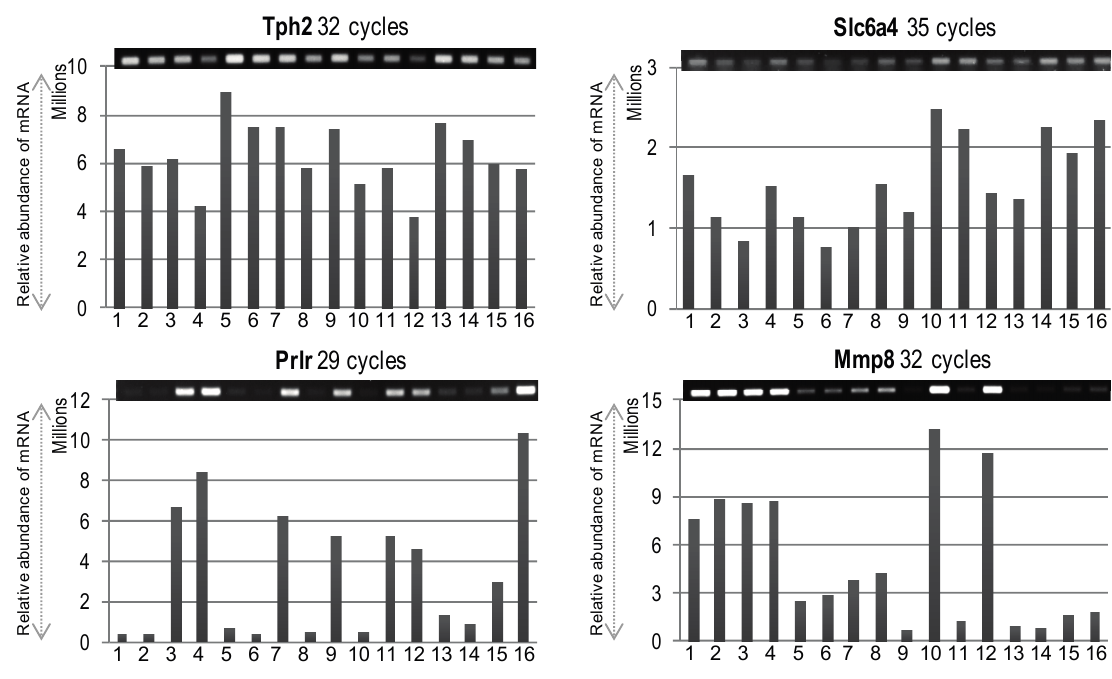
Figure 4. The mRNA expression profiles of differentially expressed down-regulated genes. Gel images on top show PCR product bands stained with ethidium bromide; band intensities are also presented graphically below for clarity. Lane numbers 1 to 8 and 9 to 16 indicate the 6 and 24 h samples ( 1 / 9 = sIC, saline Ischemic Core; 2 / 10 = pacapIC, PACAP38 Ischemic Core; 3 / 11 = sIP, saline Ischemic Penumbra; 4 / 12 = pacapIP, PACAP38 Ischemic Penumbra; 5 / 13 = sHC, saline Healthy Core; 6 / 14 = pacapHC, PACAP38 Healthy Core; 7 / 15 = sHP, saline Healthy Penumbra; 8 / 16 = pacapHP, PACAP38 Healthy Penumbra), respectively. Semi-quantitative RT-PCR was performed as described in Materials and Methods, and the gene-specific primers are detailed in Table